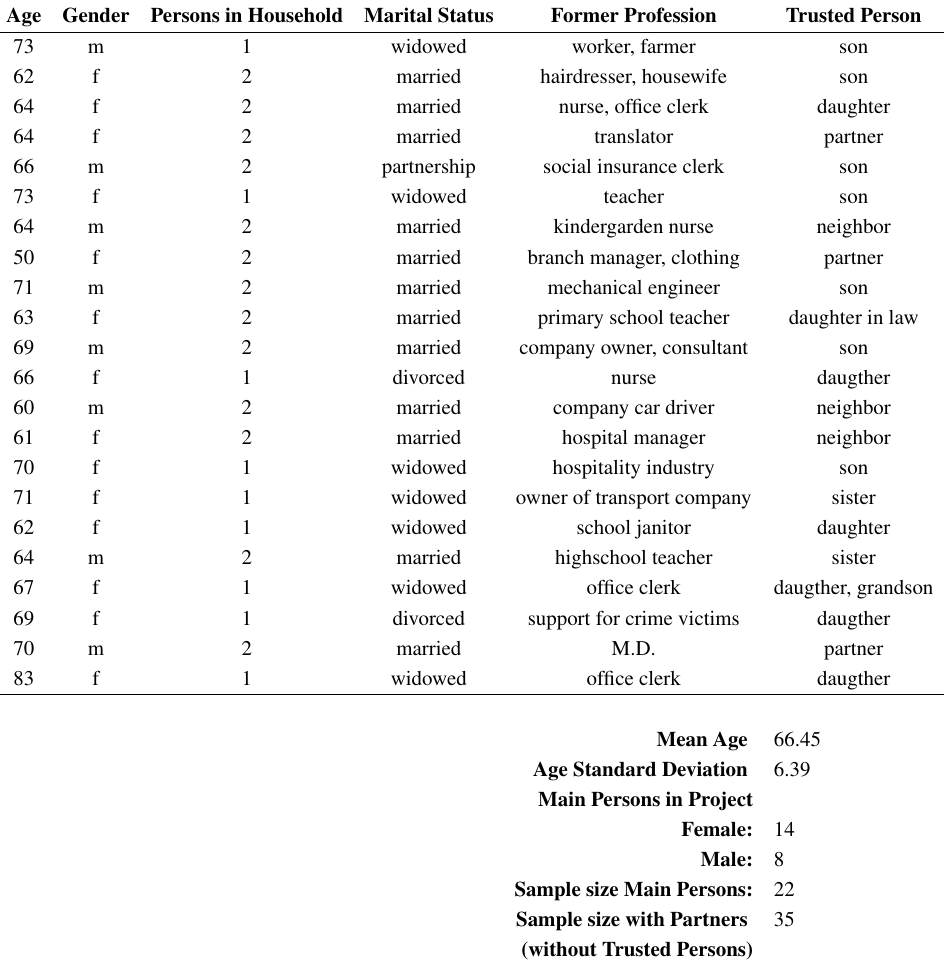
Table 1. Overview on the demographic characteristics of the Casa Vecchia